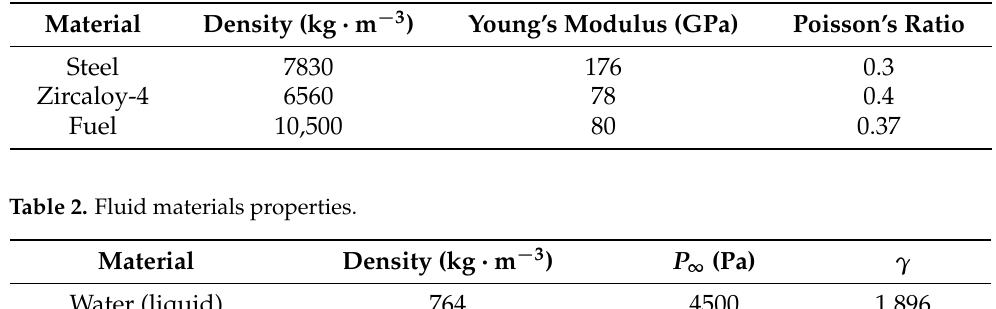
Table 1. Structure materials properties.